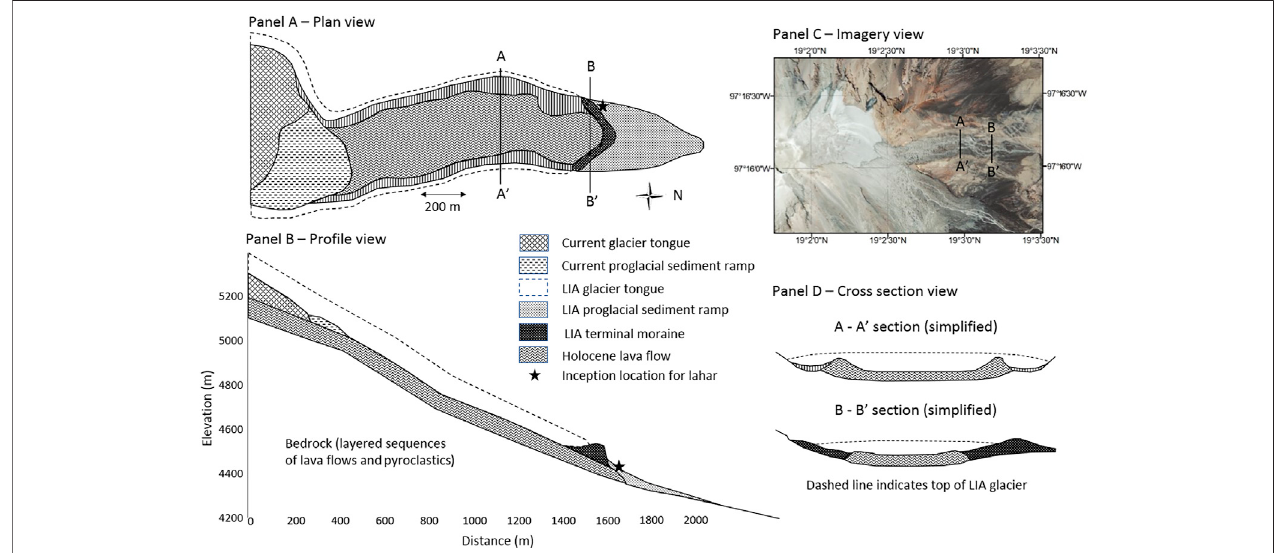
FIGURE 4 | Generalized illustration of glacial and periglacial features of the Jamapa glacial valley and former LIA glacial tongue, from the current glacial foot to the LIAproglacialrampinplanandpro fi leviewsTwosimpli fi edtransversepro fi les,A – A ′ andB – B ′ ,oftheglaciertongueandterminalmoraineareshown.Insetsatelliteimage dated